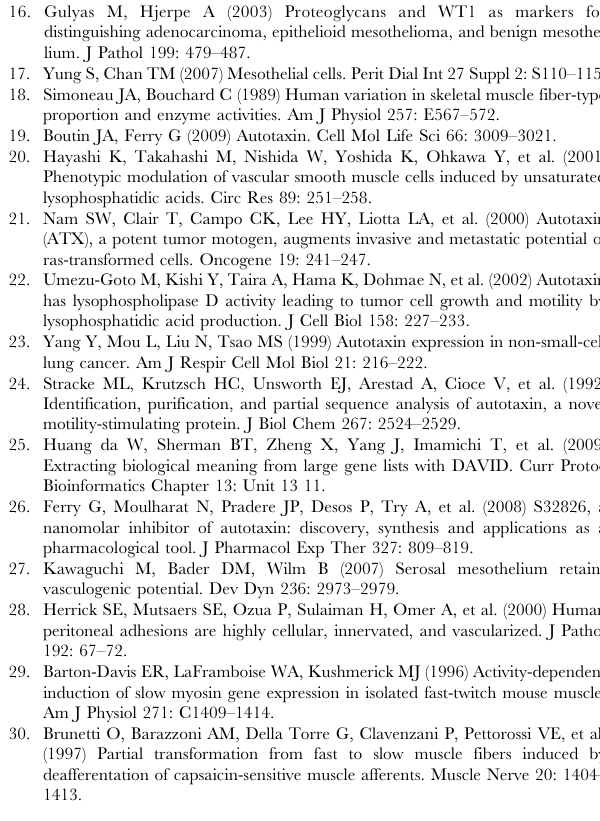
Figure S3 Visceral mesothelial cells are more contrac- tile compared to parietal mesothelial cells. Visceral and for 8 days. The area of each gel (white outline) was measured and compared to its original area (green outline). The visceral gel (A) was significantly smaller than the parietal gel (B). Areas are quantified in panel C. The asterisk represents a statistically significant difference (p , 0.05, n= 5). Error bars were calculated using standard error of the mean. Figure S4 Isolation of visceral and parietal mesothelia.